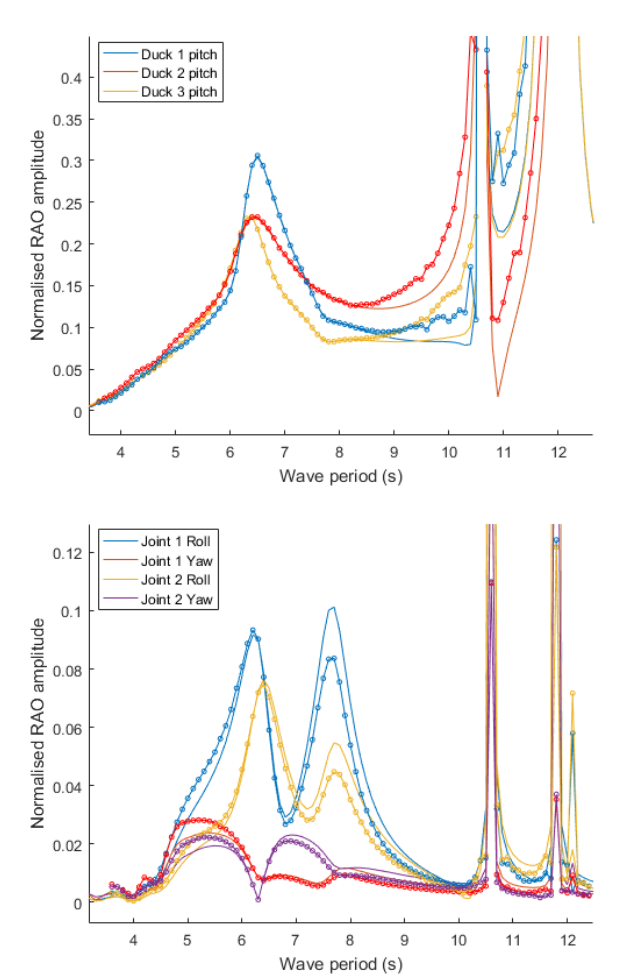
Figs. 3 (upper) and 4 (lower). Verification of the modelling approach. Solid lines with circles: time-domain approach. Solid lines: frequency-domain approach using generalized